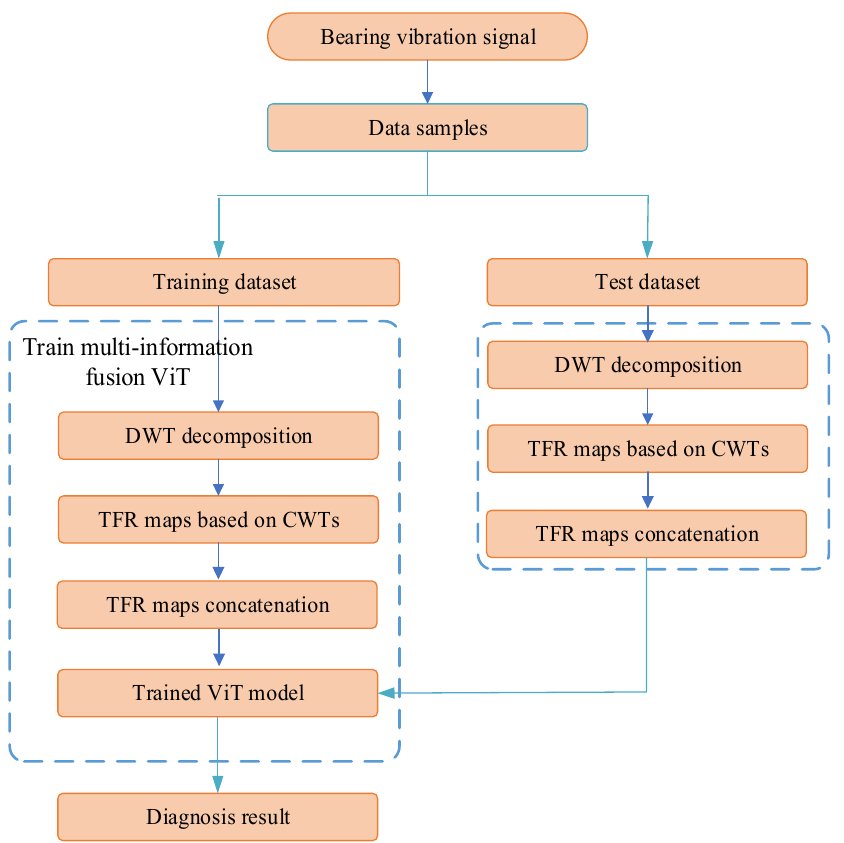
Figure 7. Fault diagnosis process of the multi ‐ information fusion ViT model.